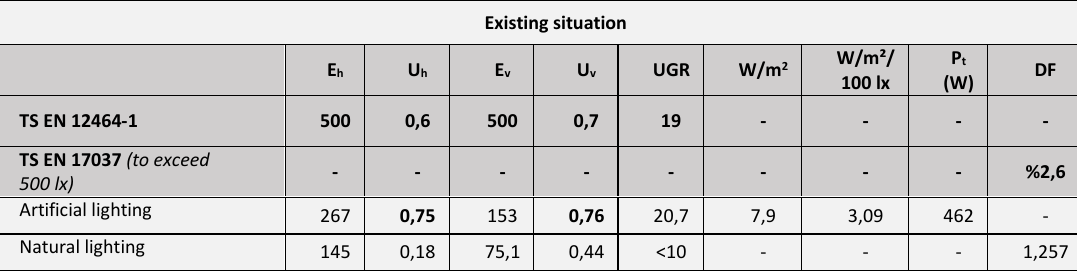
Table 8. Lighting values of existing and suggested